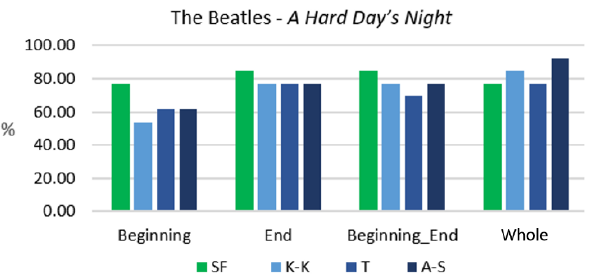
Figure 13. The key-finding efficacies obtained for the songs from the album A Hard Day’s Night by The Beatles; the samples represented with the aggregate durations of individual pitch-classes.